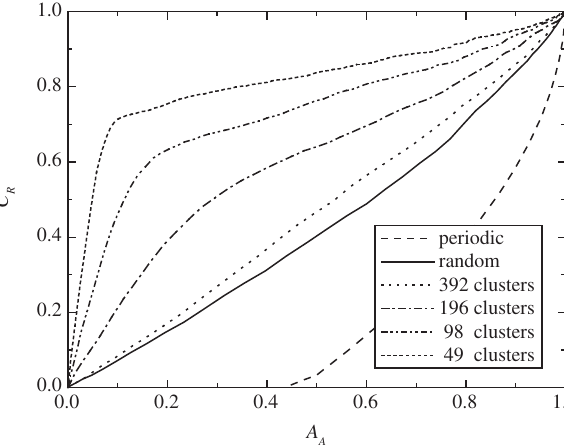
Figure 5. Contiguity, C against area fraction, simulated by R is more A